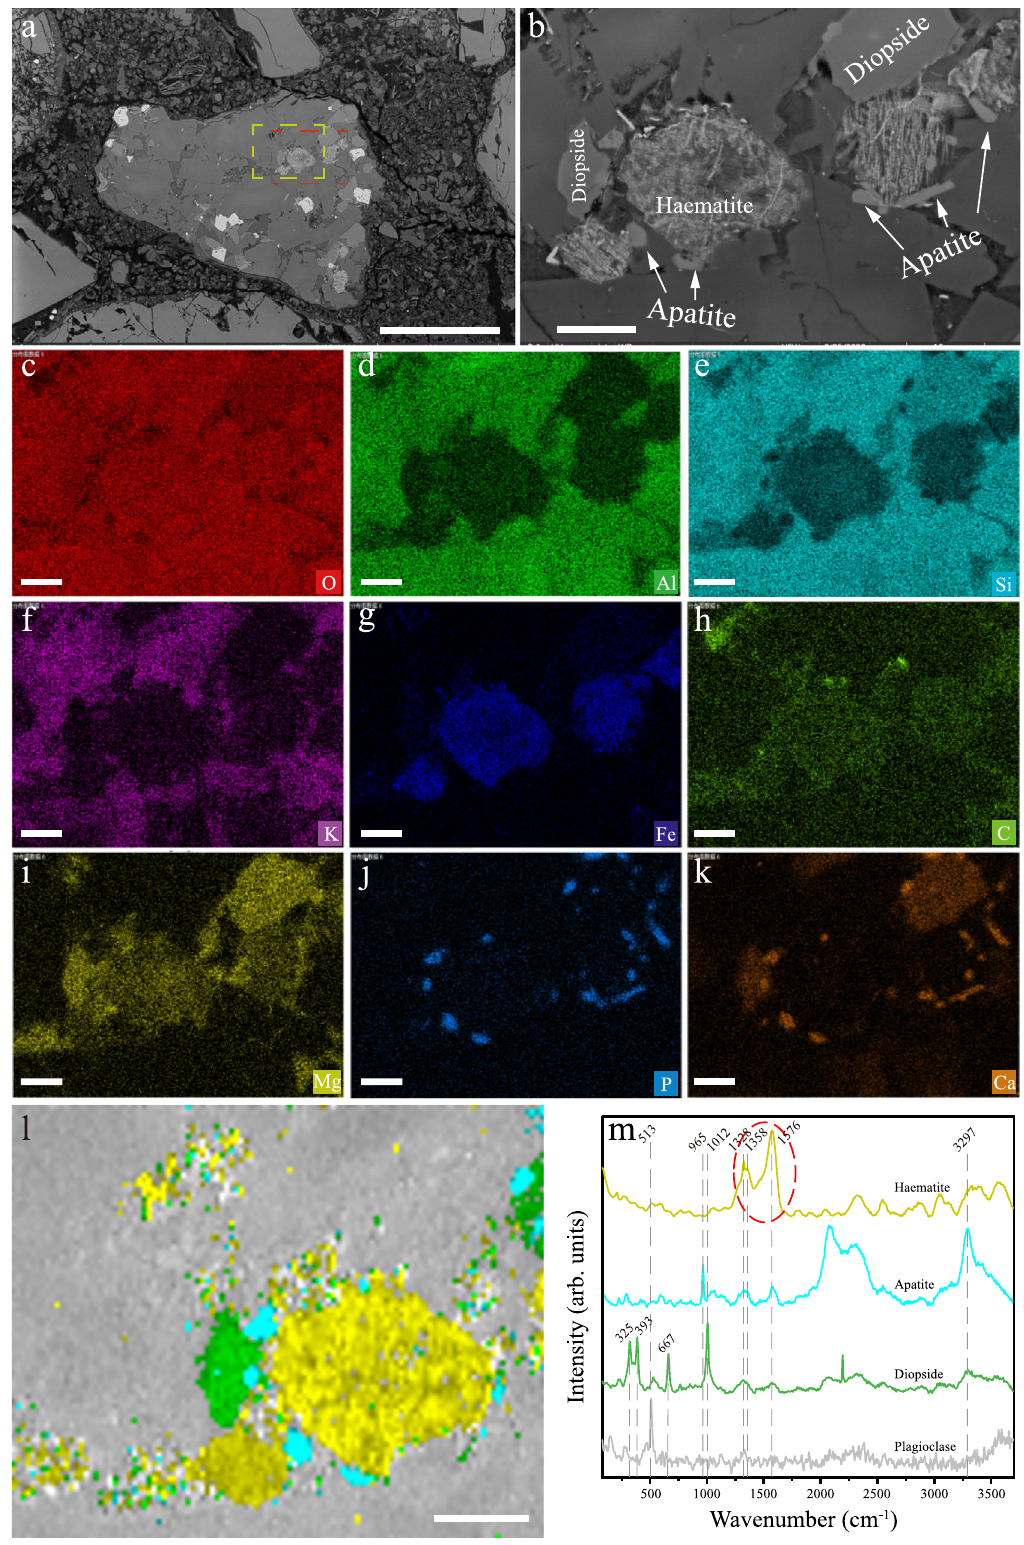
Fig. 1 Mineral alteration features in tuffs samples that may indicate microbial activity. a SEM image of altered diopside; b magni fi ed view of the red dotted box area in a ; c – k EDS surface elements scanning images of O, Al, Si, K, Fe, C, Mg, P and Ca corresponding to b ; l the combination diagram of Raman surface scanning in the box area of yellow dotted line in a . The different colors represent different minerals, as shown in yellow (hematite), cyan (apatite), green (diopside) and gray (plagioclase); m the Raman spectra of different minerals corresponding to l , the red dotted ellipse indicates the characteristic bands of carbon covalent bonds. The scale bar of a is 30 μ m, and 10 μ m for b – l .